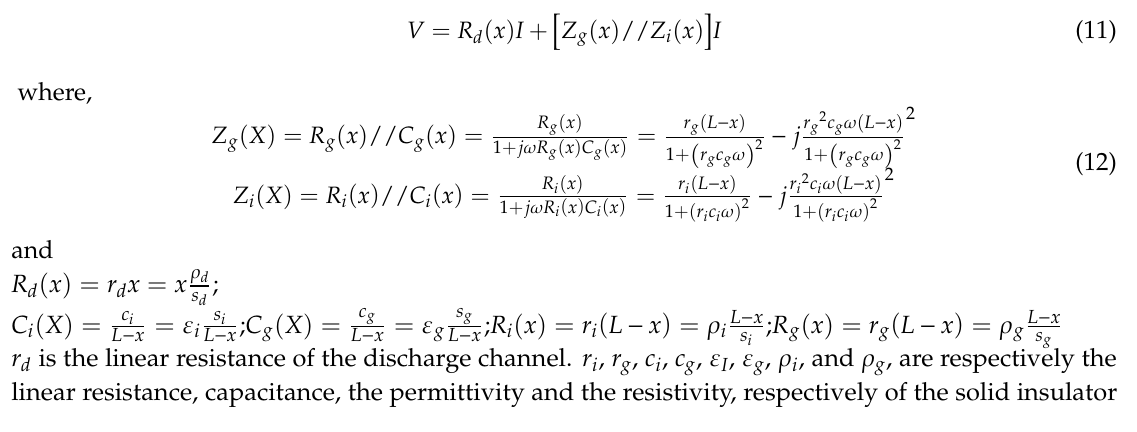
Figure 6. Insulator cylindrical model with a discharge channel and the corresponding equivalent electrical circuit.